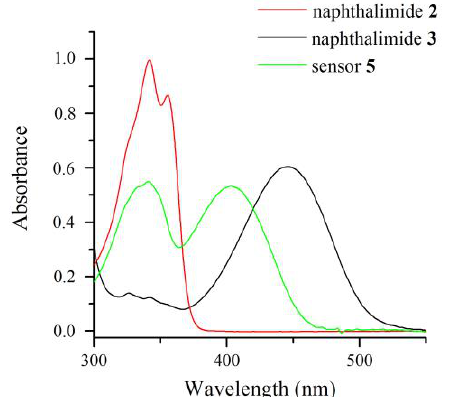
Figure 1. Absorption spectra of 1,8-naphthalimides 2 and 3 and probe 5 .